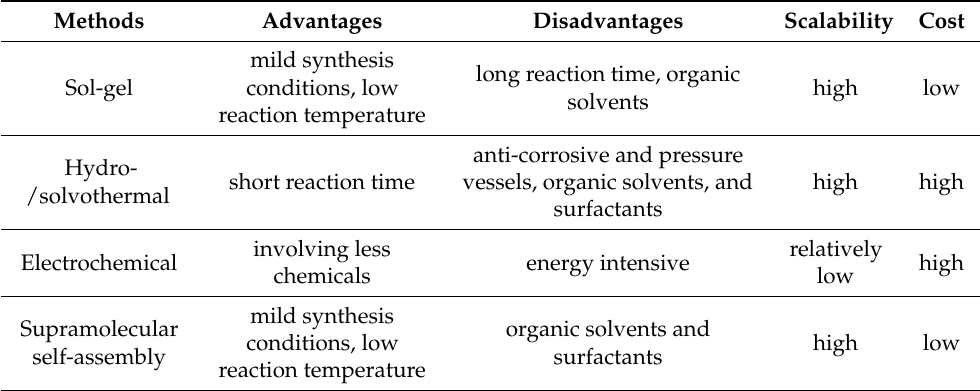
Table 1. Comparison of synthesis methods for making dendritic metal